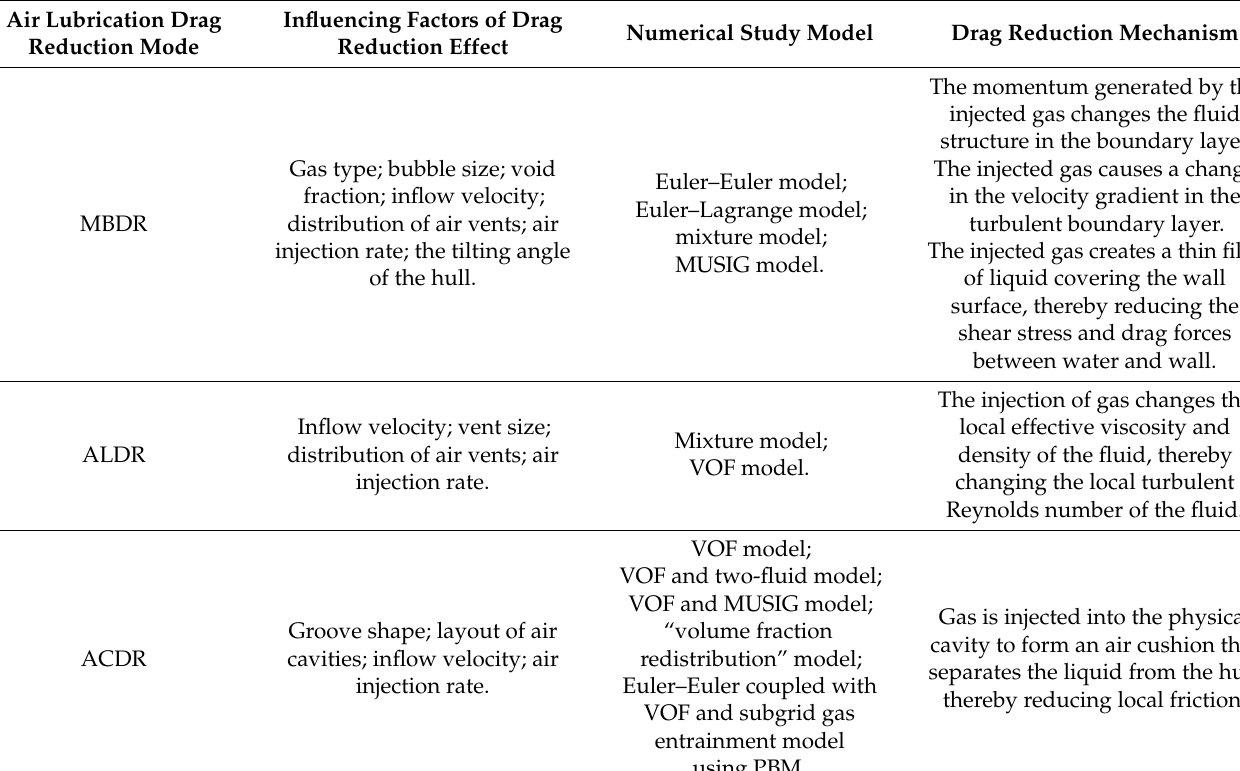
Table 1. Comparison of different types of air lubrication drag reduction